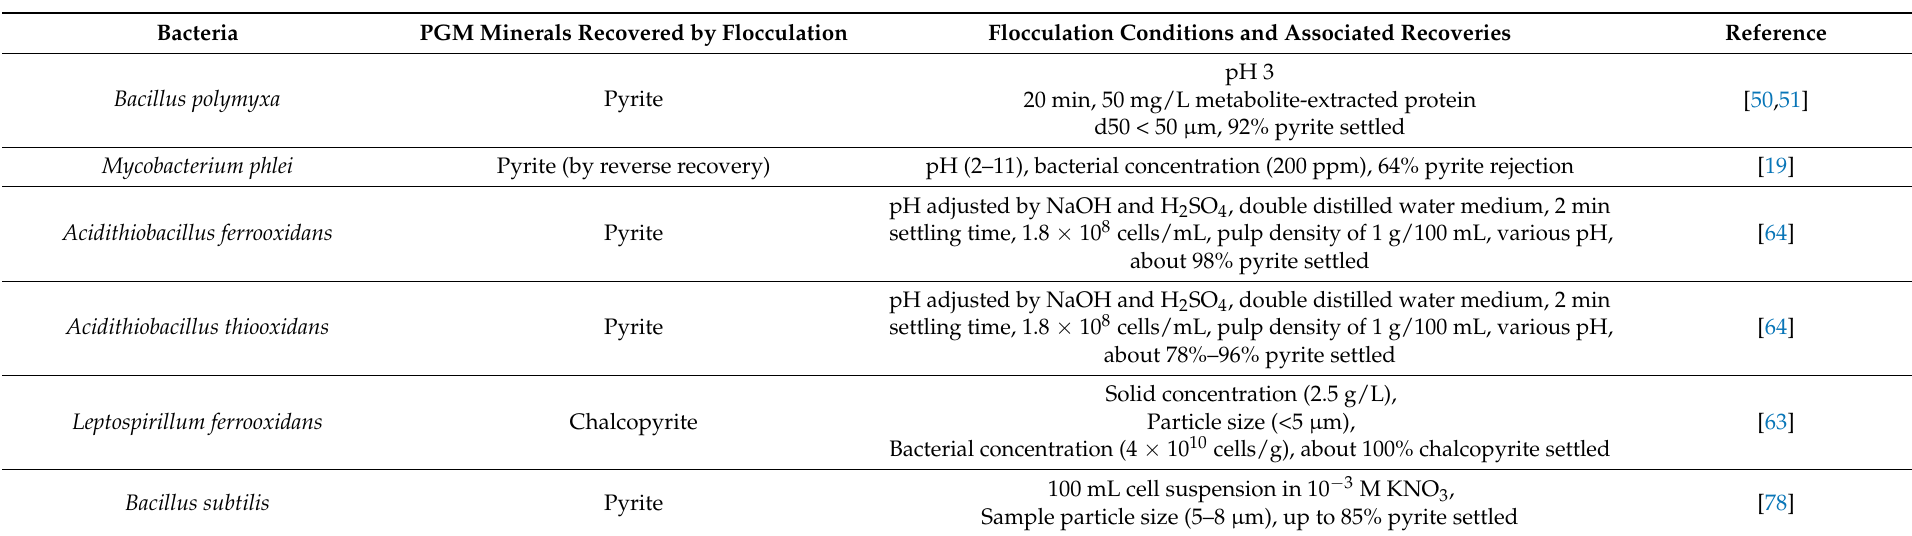
Table 6. Bacteria involved in the flocculation of PGM associated minerals and the corresponding